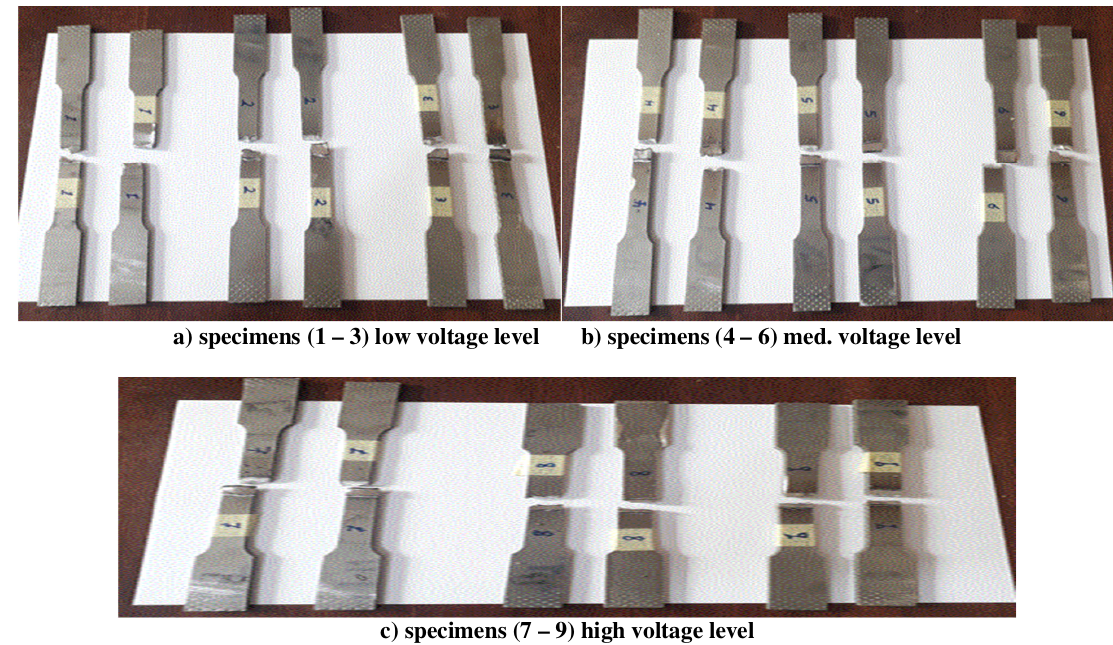
Fig. 5. tensile test specimens with three levels of arc voltage.